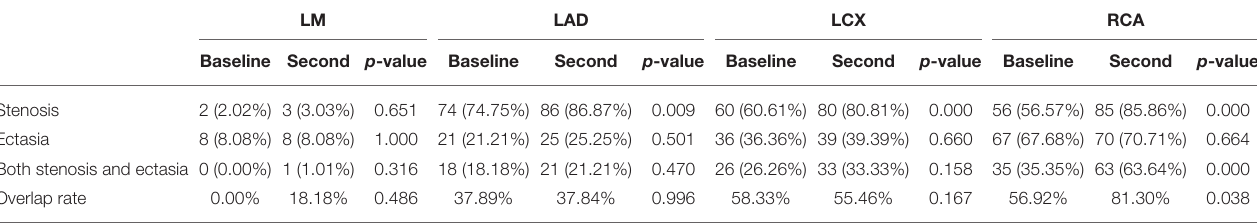
TABLE 5 | Relationship between ectasia and